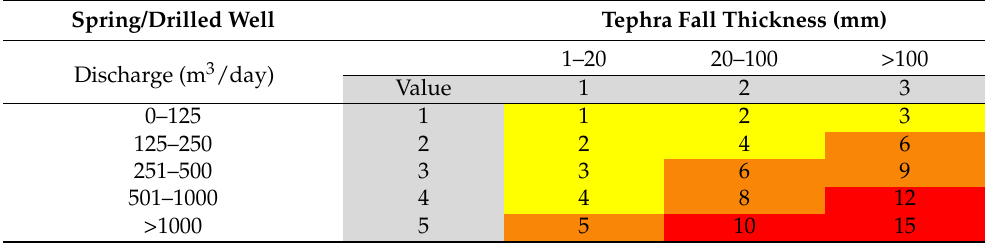
Table 2. Vulnerability matrix for the volume of water being abstracted (threshold values for tephra fall thickness adapted from [3]. Tolerance status (1–4) in yellow, disturbance in orange (5–9) and damage in red (10–15).